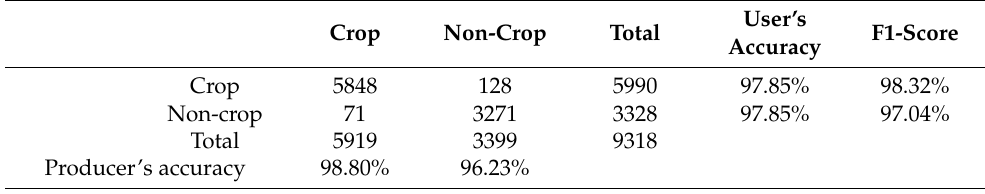
Table 2. Confusion matrix of cropland extent mapping using phenological and co-environmental